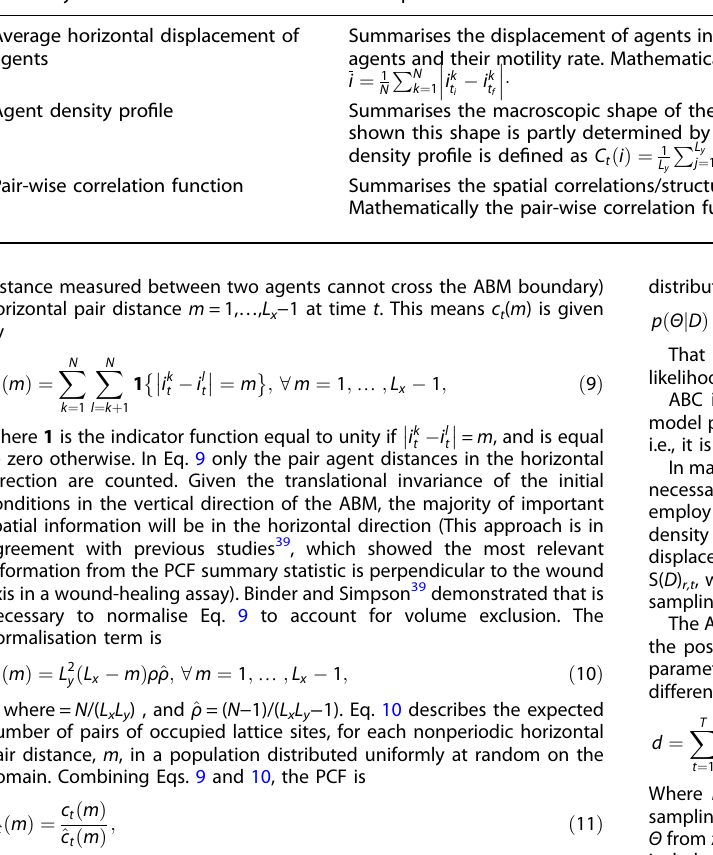
Approximate Bayesian computation